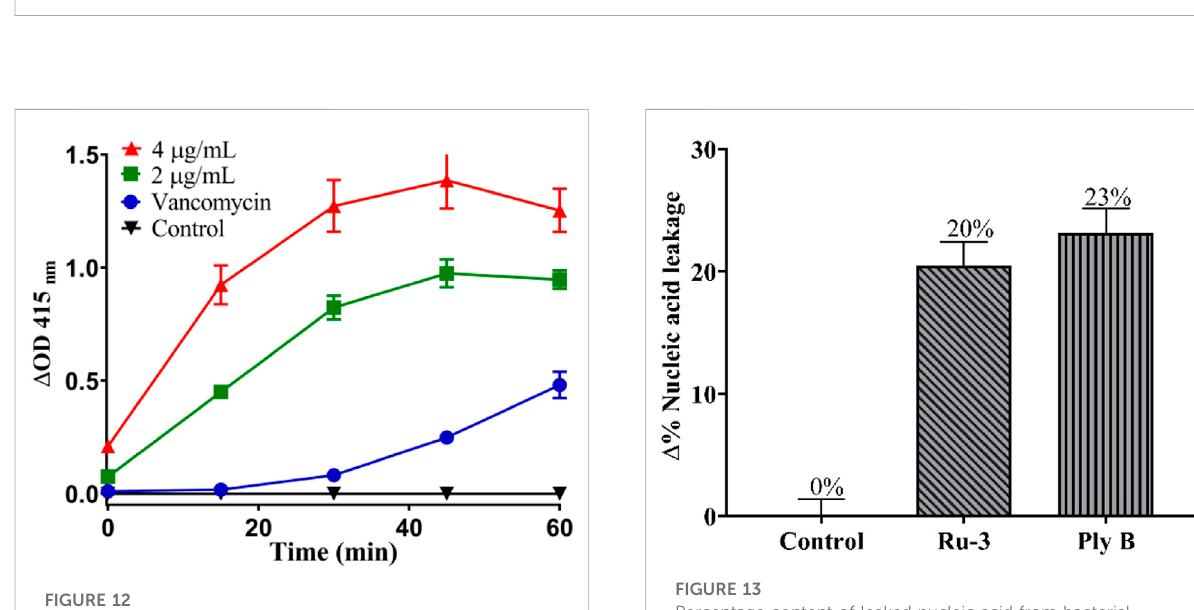
FIGURE 13 Percentage content of leaked nucleic acid from bacterial cells with the treatment of Ru-3 (4 μ g/ml) or Ply B (Polymyxin B, 100 μ